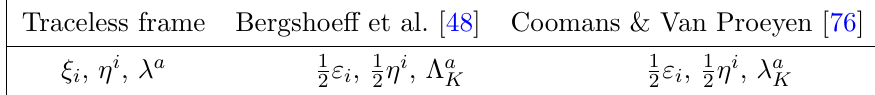
Table 2 . Transformation parameters for (cid:14) Q + (cid:14) S + (cid:14) K . Open